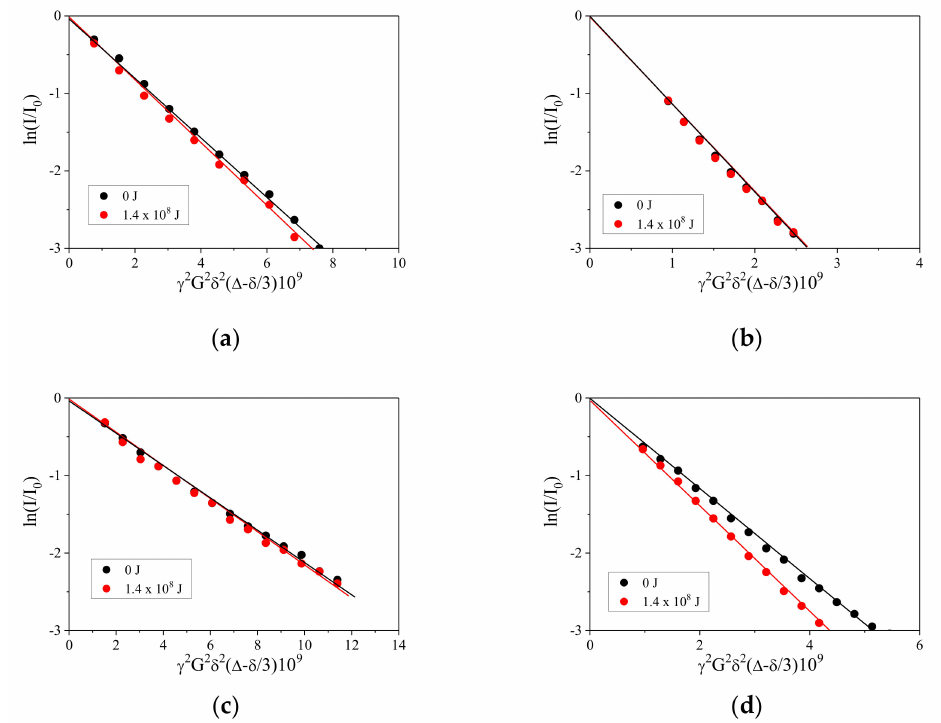
Figure 5. Examples of PFG-NMR spin-echo signal attenuation plots of respective surfactants in aqueous CaCO 3 particle suspensions: ( a ) Triton X-100, ( b ) SDS, ( c ) Softanol-70, and ( d ) CTAB at δ = 1 ms for diffusion time of ∆ = 50 ms. The solid line represents linear regression. Black circles and lines are for the samples before wet-jet milling. Red colored circles and lines are for the samples dispersed at the highest dispersing energy input (approximately 1.4 × 10 7 J). Based on the Stokes– Einstein assumption, the estimated micellar size of the surfactants is approximately 1–8